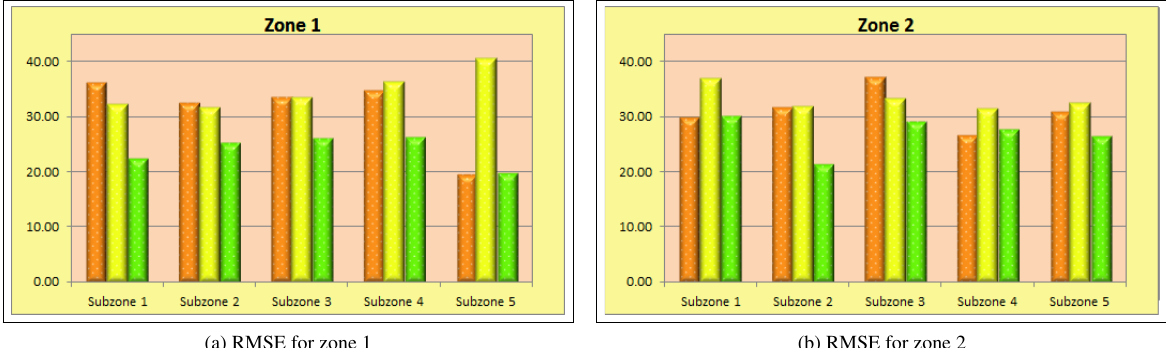
Figure 6. Temporal-semantic semivariogram with respect to LST Figure 7. Temporal-semantic semivariogram with respect to NDVI